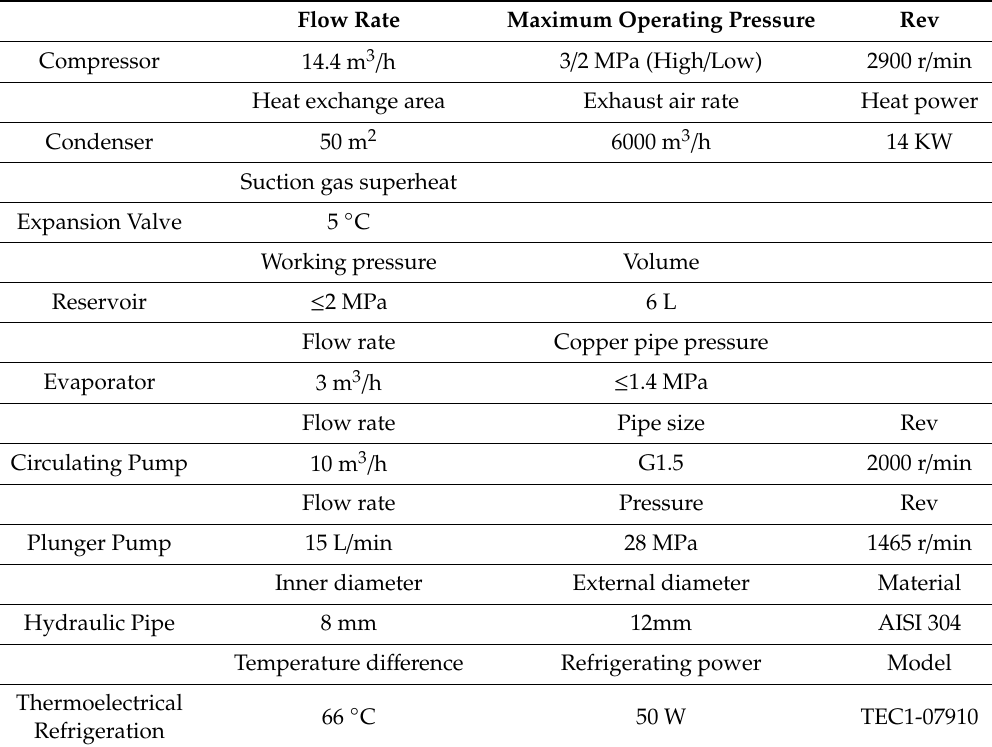
Table 1. Key component parameters in